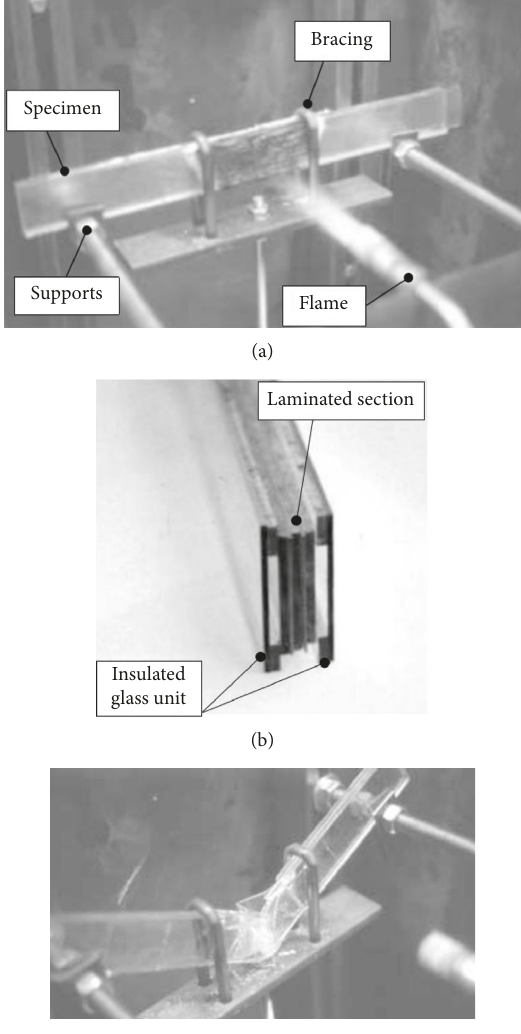
(c) Figure 14: Summary of fire experiments carried out in [22]. (a) Four-point bending setup (in evidence, the foam layer provided by intumescent paint (specimens A)), (b) cross-section features of specimens E, and (c) buckling of segmented beams (type